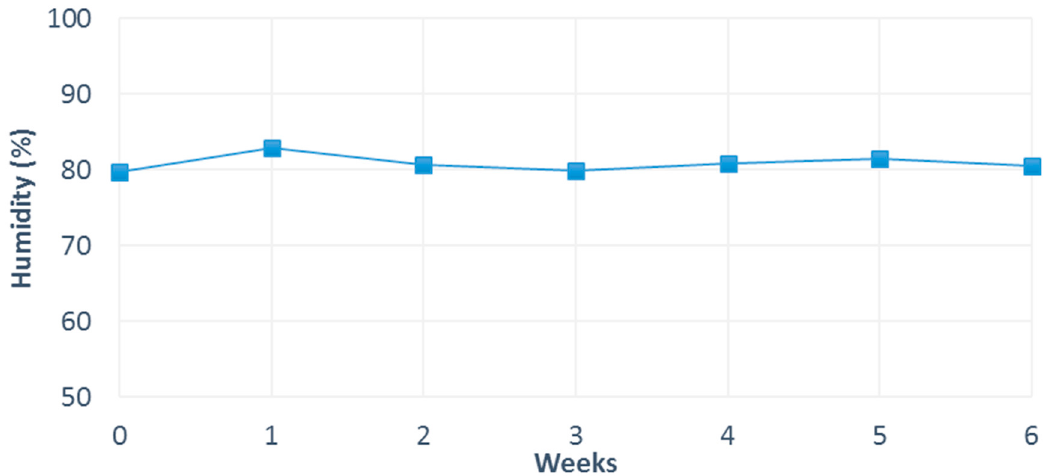
Figure 3. Humidity behavior in pineapple waste during the pre-composting process.